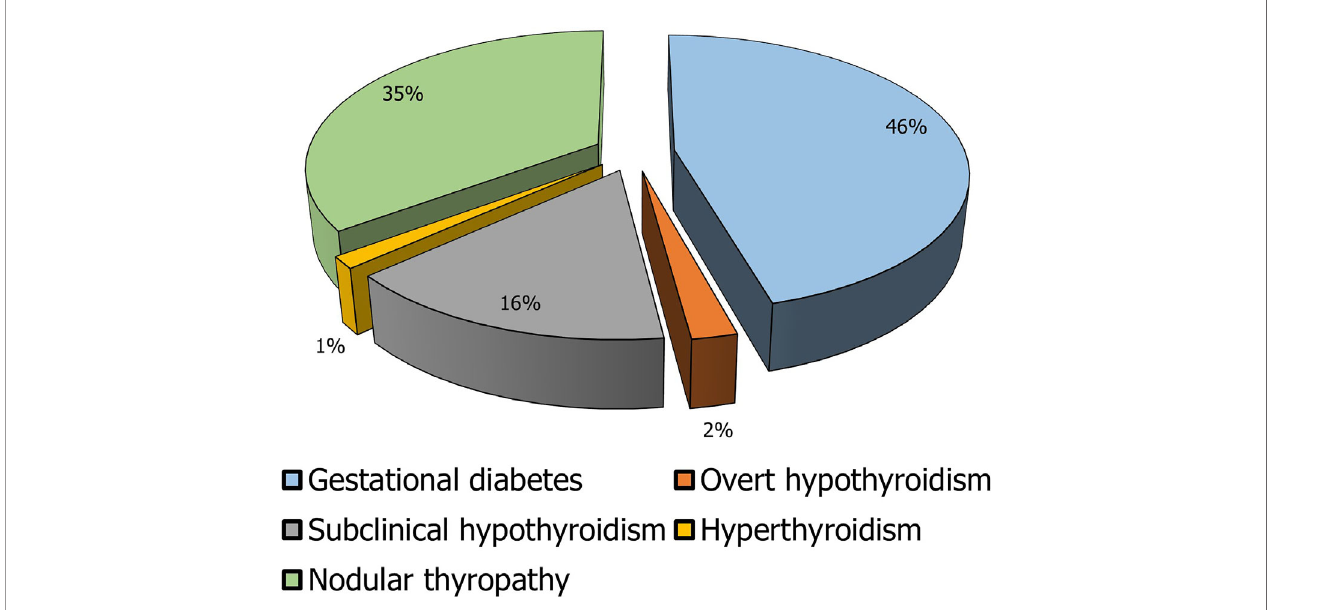
FIGURE 1 | Prevalence of the main endocrine diseases in pregnancy. In the elaboration of the pie chart, the prevalence data have been applied to the number of pregnancies in 2018 in Italy calculated as the sum of the number of deliveries, the number of miscarriages, and the number of voluntary interruptions of pregnancy (117, 118).